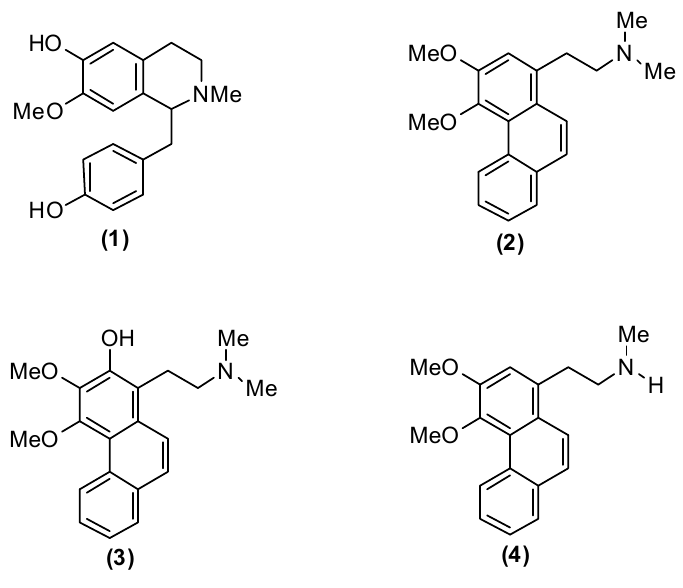
Figure 1. Structures of compounds 1 – 4